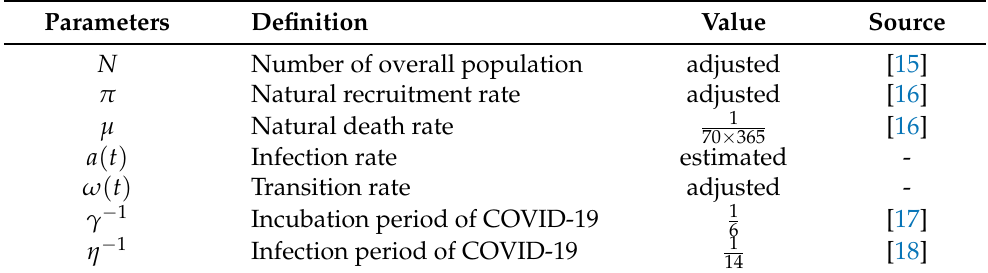
Table 1. Descriptions of parameters given in system (1) and